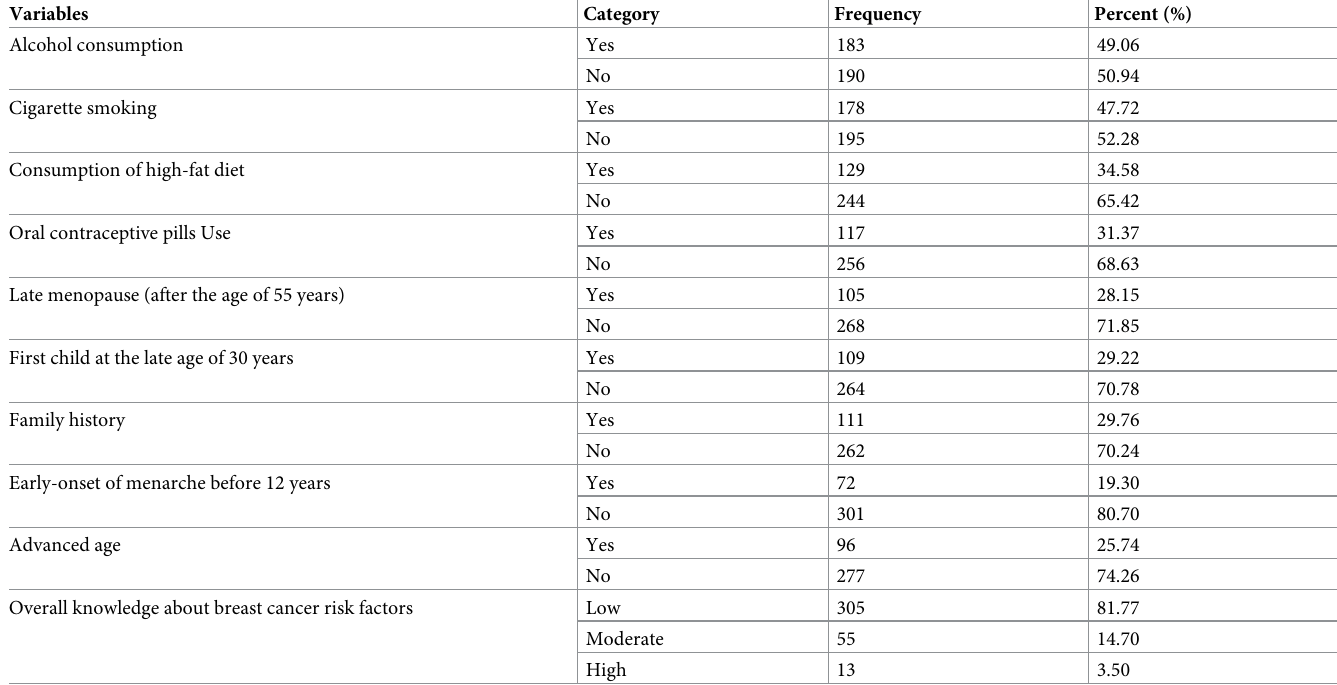
Table 2. Knowledge of young adult women on breast cancer risk factors Gurage